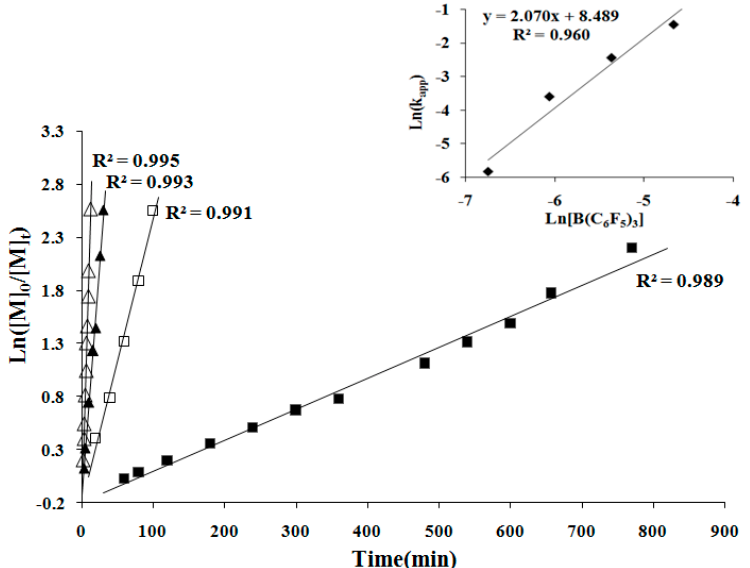
Figure 5. First-order kinetic plots for MMBL polymerization by i Bu SKA/B(C 6 F 5 ) 3 in CH 2 Cl 2 at RT: [MMBL] 0 = 0.936 M; [SKA] 0 = 2.34 mM; [B(C 6 F 5 ) 3 ] 0 = 9.36 mM ( ∆ ), 4.68 mM ( ▲ ), 2.34 mM ( □ ), 1.17